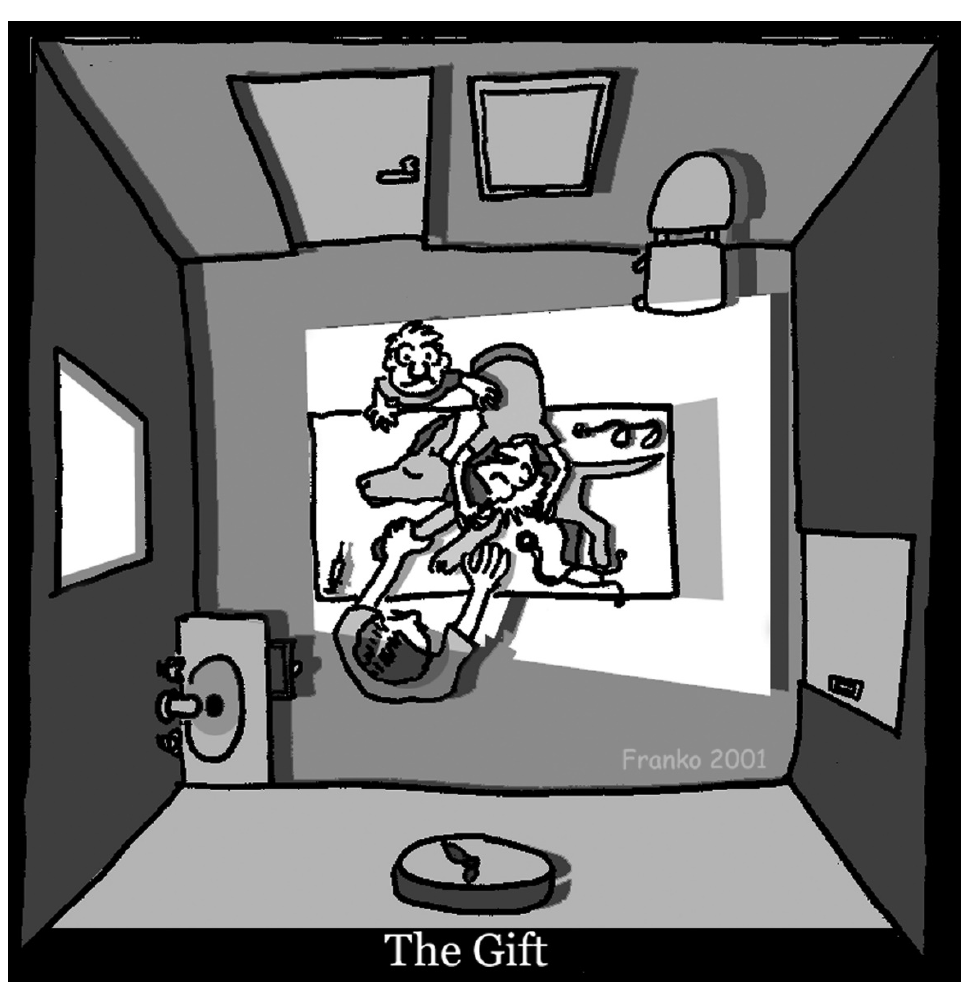
Figure 1. “The Gift” by veterinarian and animator Frank Gaschk.